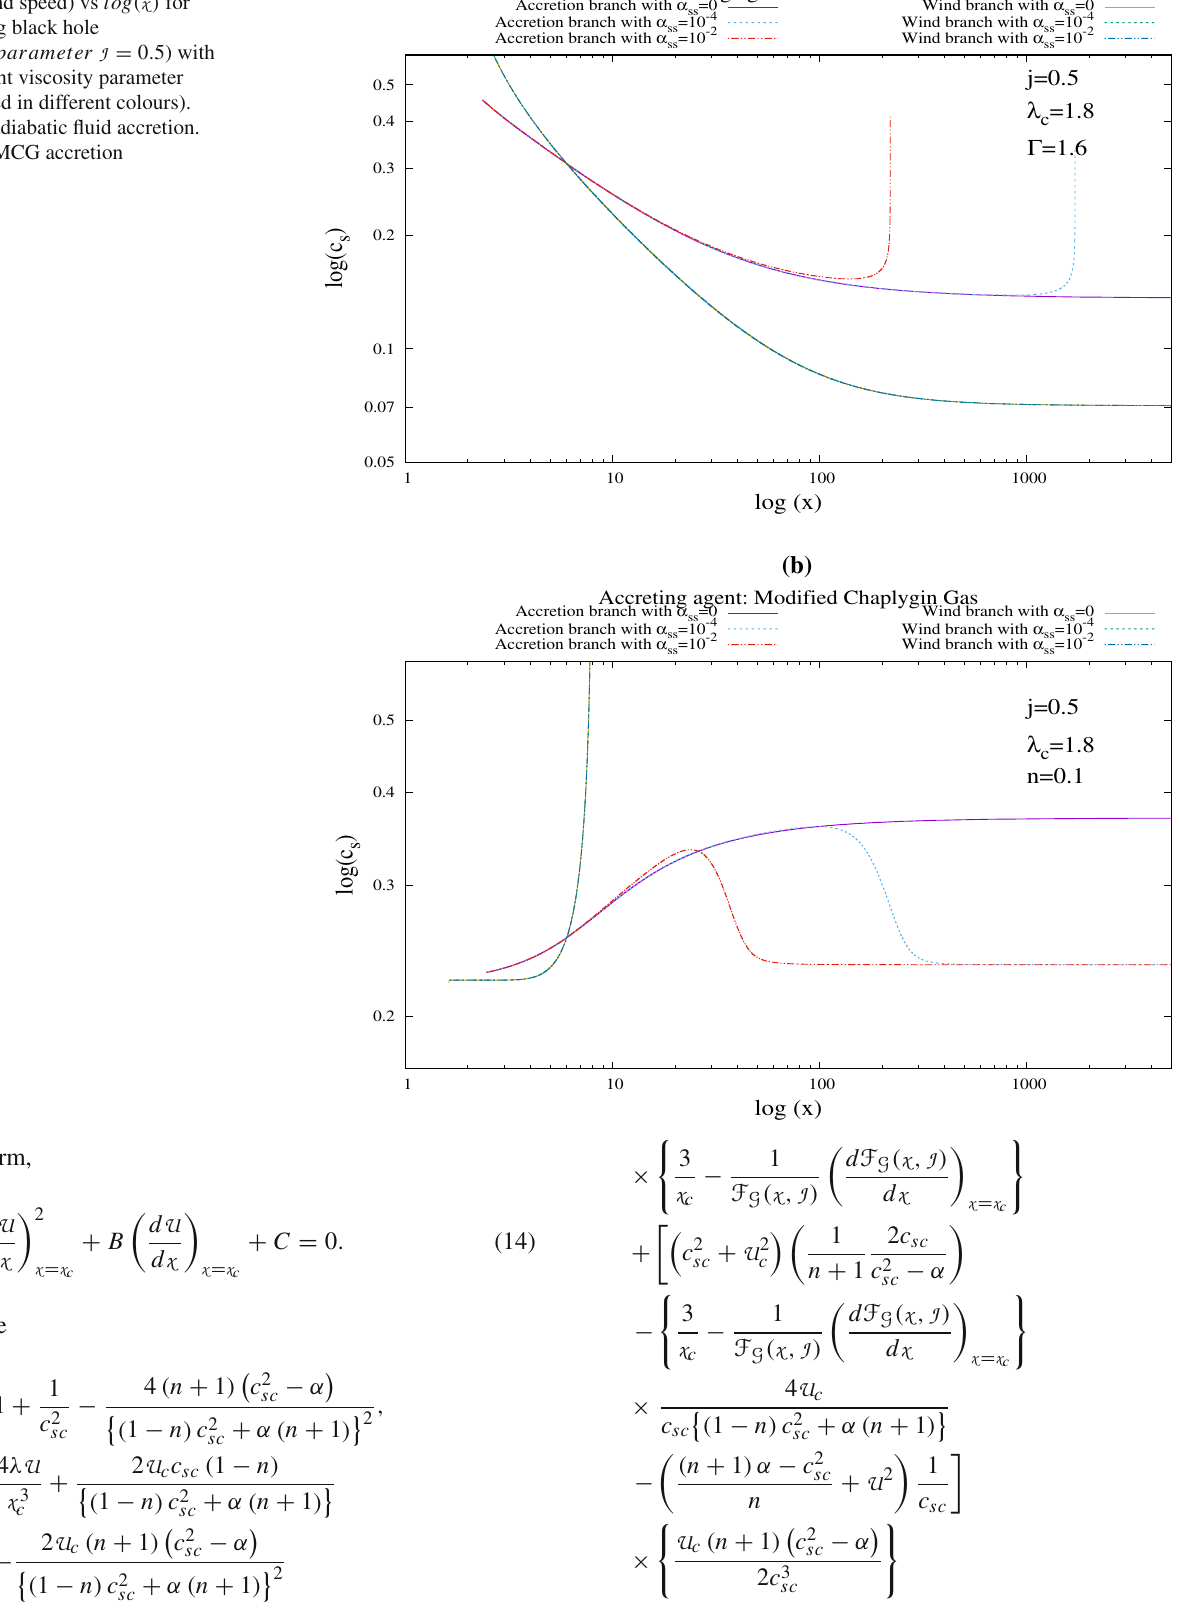
Fig. 2 Plots of accretion and wind branches for log ( c s ) (log of sound speed) vs log ( x ) for rotating black hole ( spin parameter J = 0 . 5) with different viscosity parameter (showed in different colours). a For adiabatic fluid accretion. b For MCG